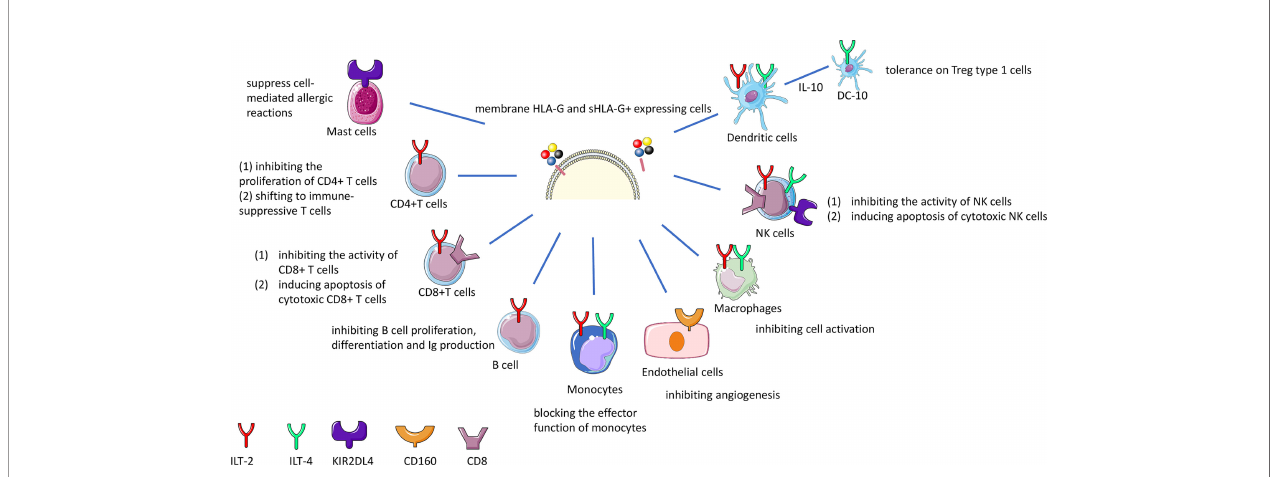
FIGURE 2 | HLA-G immune inhibition by interaction with receptors on effector cells. sHLA-G and membrane bound HLA-G molecules interact with the ILT-2 and ILT-4 receptor on T, NK, B cells and macrophages resulting in the inhibition of cytotoxicity, proliferation, or antibody production. The interaction of HLA-G with CD8 coreceptor on certain T and NK cell population leads to the deletion of these cells. Long-term tolerance will be achieved by the induction of different types of regulatory T (Treg) cells. HLA-G and KIR2DL4 interaction on mast cells suppresses mediation of allergic